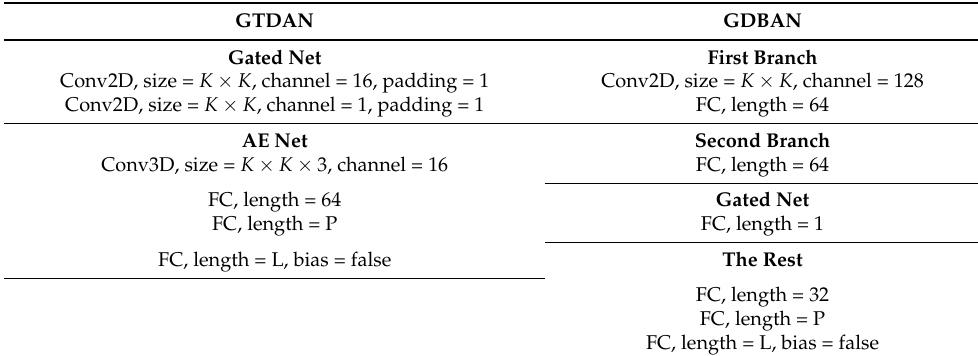
Table 1. Network configuration of the proposed architectures. The number of input channel is